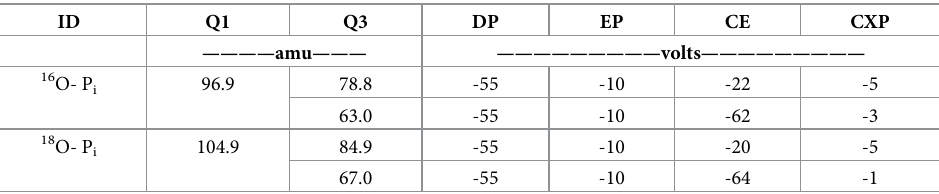
Q1, quantifier precursor ion; Q3, quantifier product ions; DP, declustering potential; EP, entrance potential; CE, collision energy; CXP, Collision cell exit potential; amu, atomic mass unit (Daltons); 16 O- P i ; 16 O-orthophosphate; 18 O- P 18 i ,